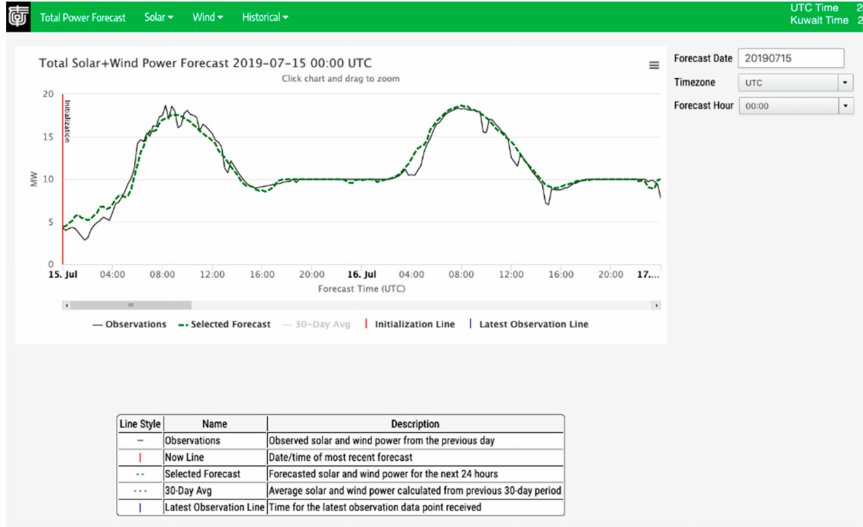
Figure 18. Historical total power forecast issued on 15 Jul 2019 at 00